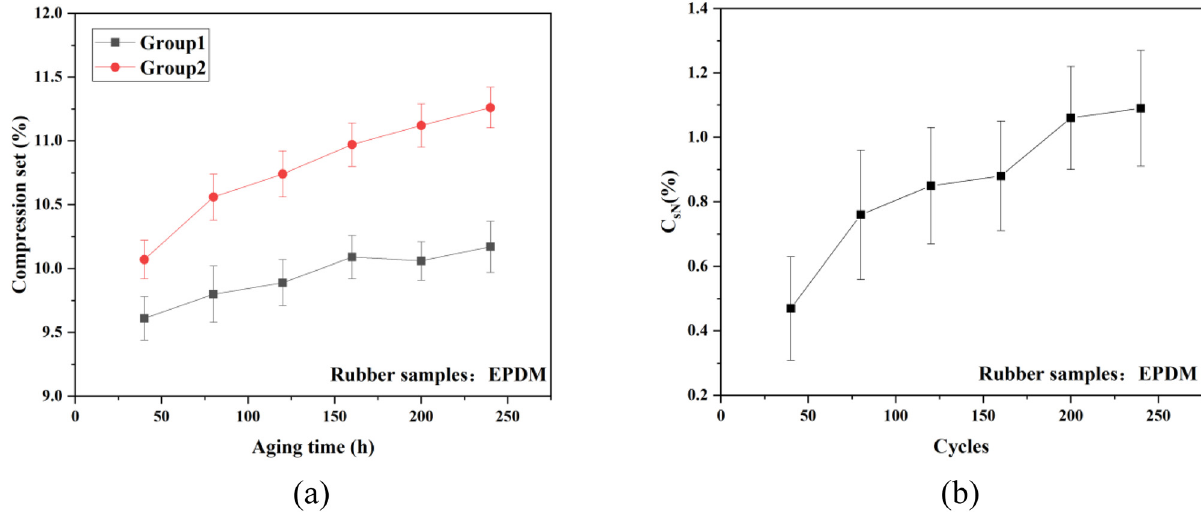
Figure 5: Compression set test results of EPDM under ( a ) di ff erent environmental aging and ( b ) di ff erent cycle number N